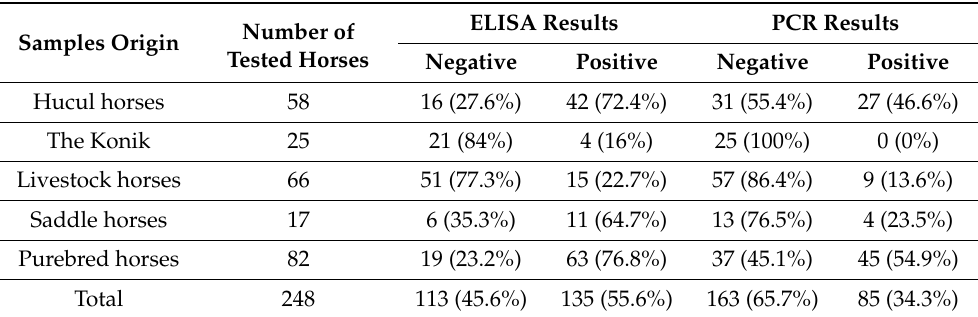
Table 2. Summary of EFVeca Gag ELISA and PCR results in the groups of horses determined by their origin.